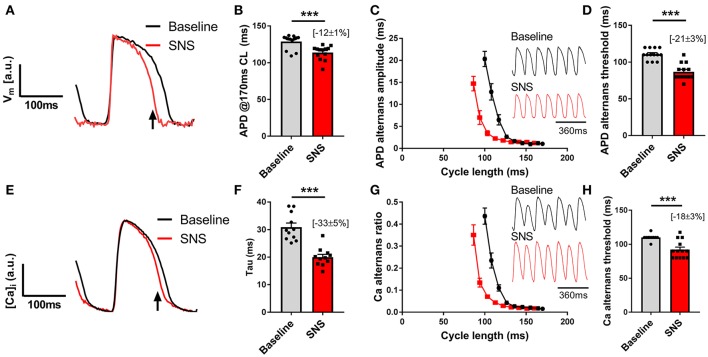
Effects of sympathetic nerve stimulation on action potential duration and Ca transient alternans. (A,B) Representative traces and data showing the change in action potential duration (APD) with sympathetic nerve stimulation (SNS). CL, cycle length. (C) Representative optical action potential recordings during pacing at a 120 ms cycle length and average cycle length relationships for the magnitude of APD alternans at baseline (black) and during SNS (red). (D) Data showing the change in the APD alternans threshold with SNS. (E,F) Representative trace showing the change in Ca transient kinetics with SNS and data demonstrating the effects of SNS on the time constant (tau) of Ca transient decay. (G) Representative optical Ca transient recordings during pacing at a 120 ms cycle length and average cycle length relationships for the magnitude of the Ca alternans ratio at baseline and during SNS. (H) Data showing the change in the Ca alternans threshold with SNS. Data taken from a 3 x 3 pixel region in the basal left ventricle. Data represent mean ± SEM. Paired Student's t-tests; ***p < 0.001. (n = 11–13 hearts).